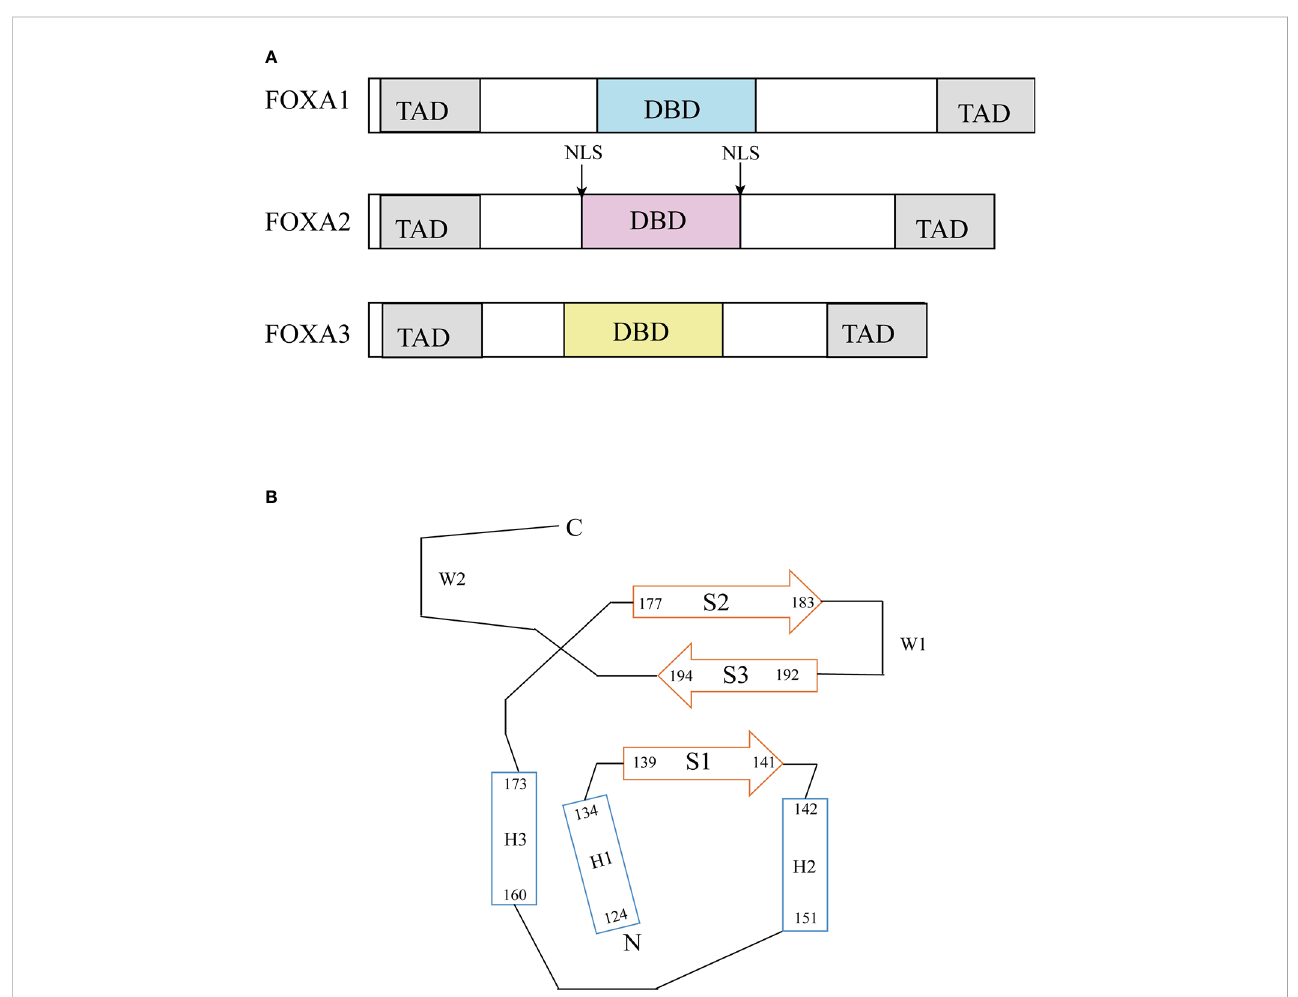
FIGURE 2 Structure of FOXA. (A) Functional domains of FOXA family (23). FOXA1, 2 and 3 have substantial homology in the DNA binding domain, FOXA1 has 95% sequence homology with FOXA3 and 90% homology with FOXA2 (24). (B) Topology of FOXA3 DNA binding domain (24). DBD, DNA-binding domain; TAD, transactivation domain; NLS, nuclear localization